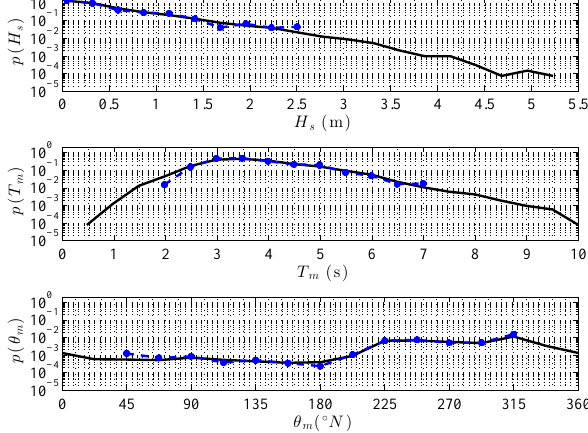
Figure 6. Single-step SOM: comparison of original (black solid line) and resulting (blue dashed dots histograms representing the PDFs of H s (top panel), T m (central panel) and θ m (bottom panel), for the whole data